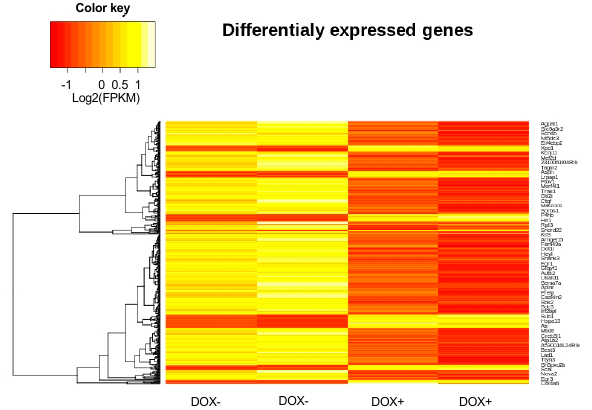
Figure 7. Changes in transcriptome due to acute SERCA2a overexpression in CASQ2 KO hearts. Heat map showing gene expression in hearts from KO-TG before and after induction of SERCA overexpression.